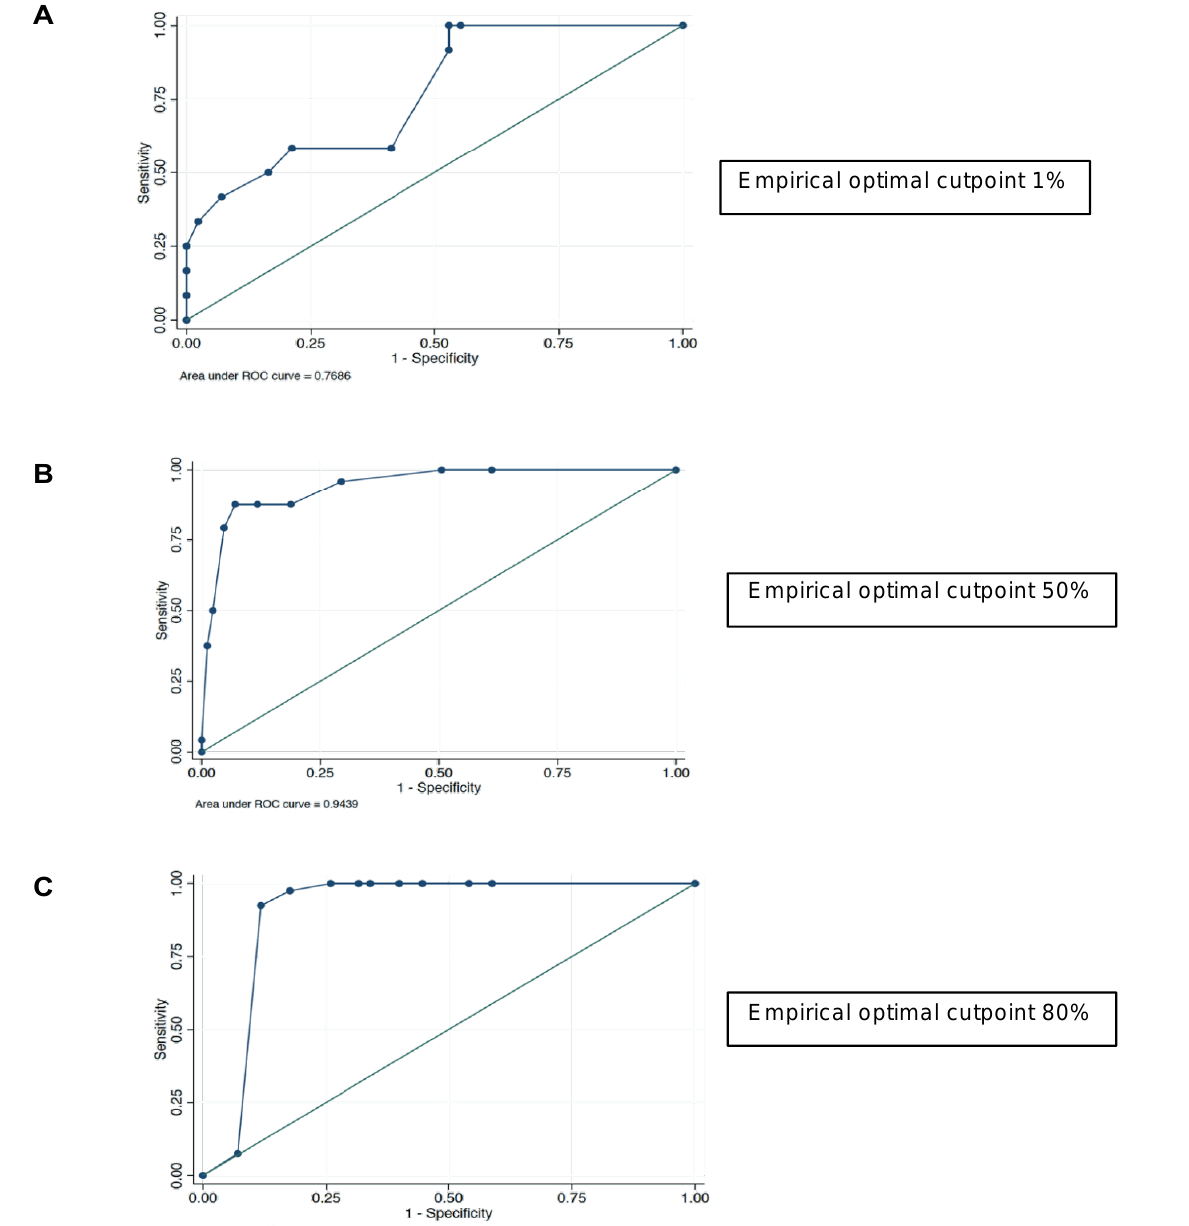
Figure 2. Receiver operating characteristic (ROC) curve analysis used to identify the optimal cutoff point capable of detecting a tumor-derived sample. ( A ) Immunohistochemistry (IHC) intensity 1: the threshold identified was 1% p65BTK positivity. ( B ) IHC intensity 2: the threshold identified was 50% p65BTK positivity. ( C ) IHC intensity 3: the threshold identified was 80% p65BTK positivity.